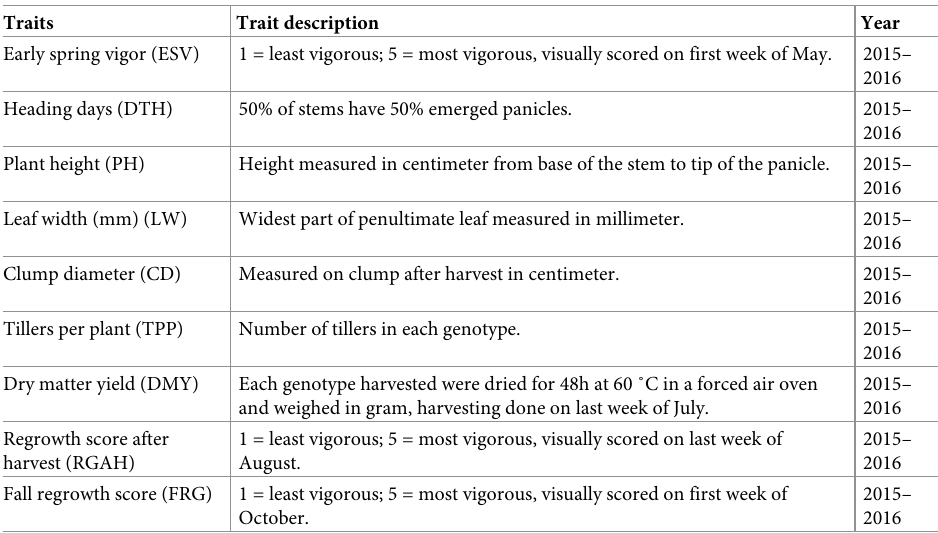
Table 2. Description of the measurement of agro-morphological